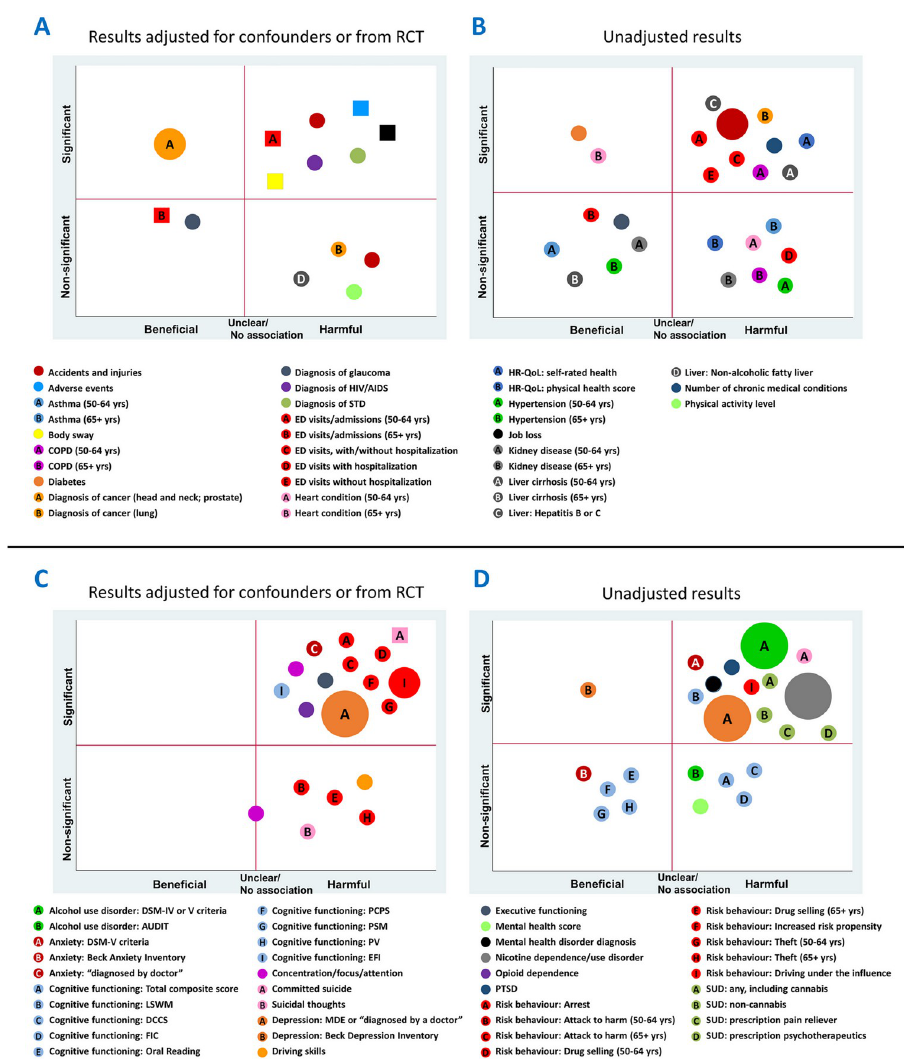
Fig 5. Bubble plots of findings from population-based studies and studies of healthy older adults. Findings at a glance: Observed associations of cannabis use with physical health outcomes (Panels A, B) and mental health outcomes (Panels C, D), with separate plots for adjusted analyses/RCTs and unadjusted analyses. Some associations were derived from studies with cross-sectional and case-control designs (circles), while others were derived from cohort studies and RCT (squares). Quadrants of plots represent significant and non-significant beneficial and harmful effects. Each bubble represents an outcome definition for which at least one study reported an effect within a plot quadrant. Bubble size represents the number of studies that reported that outcome definition in the quadrant. Letters within bubbles denote subgroups or different outcome definitions within an outcome